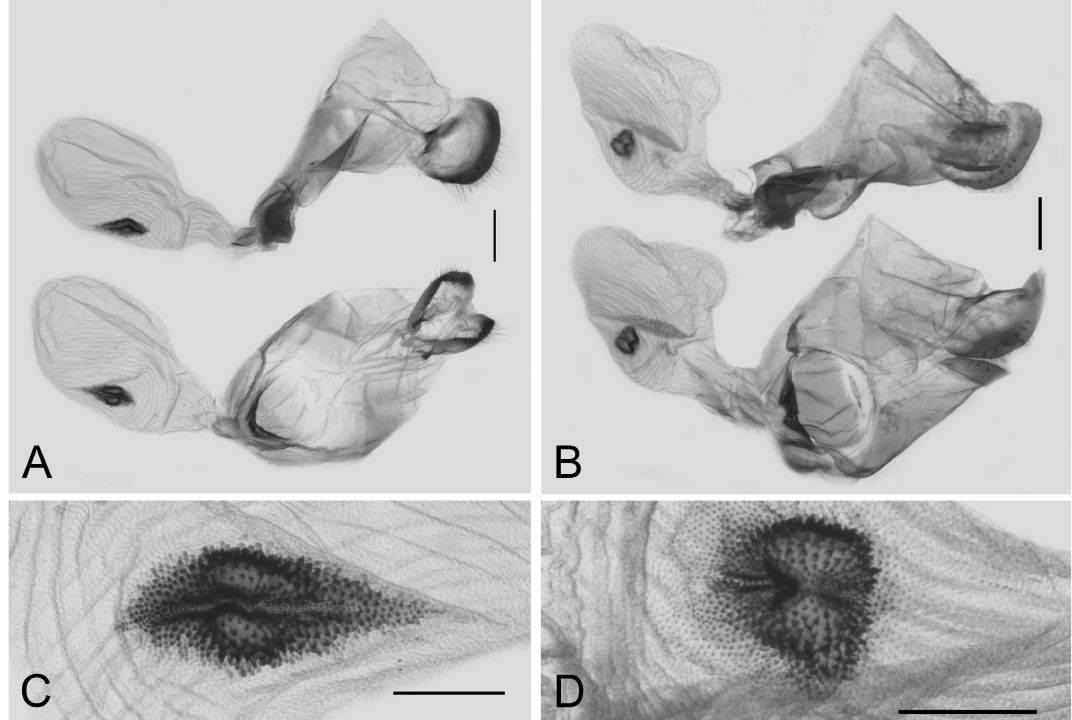
Figure 6. Comparison of female genitalia of Losaria coon coon ( A ) and L. doubledayi ( B ), scale bars = 1.0 mm; with enlarged signum ( C ) and ( D ), scale bars = 0.5